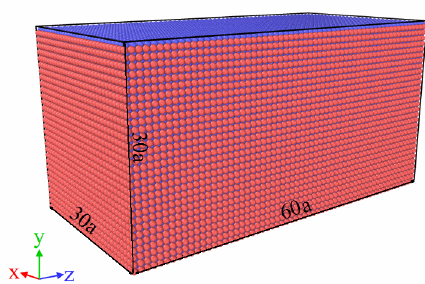
Figure 2. Initial structure of the molecular-dynamics (MD) model with a B2 cubic phase containing 108,000 atoms.